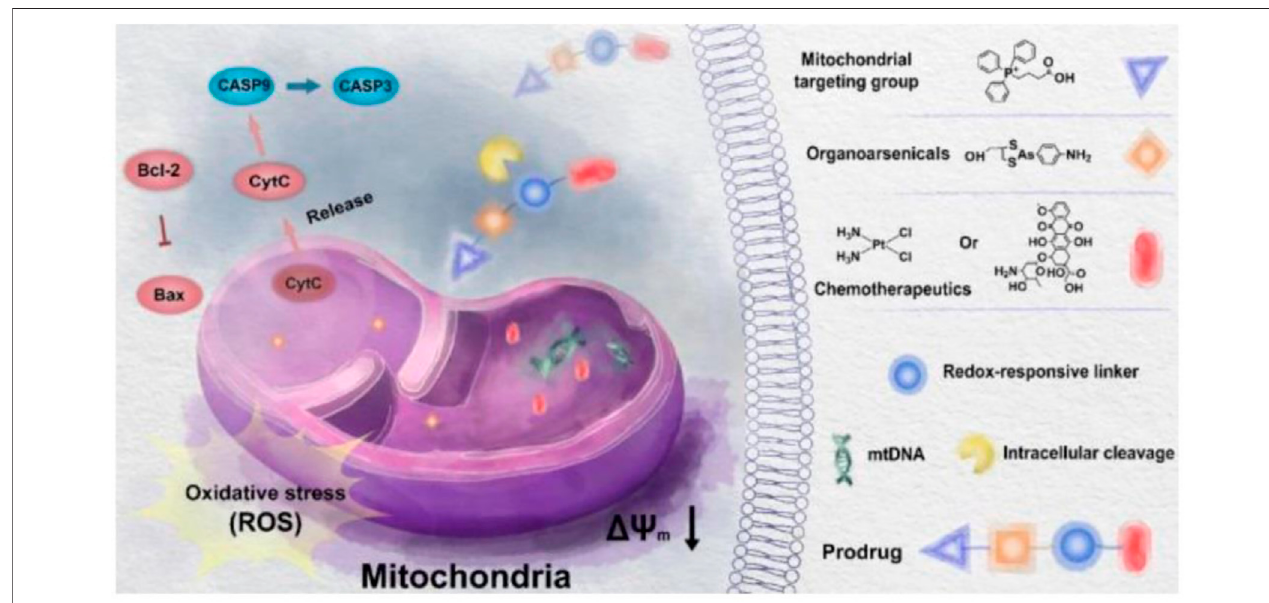
FIGURE 6 | Illustration mechanism of underlying mitochondria targeting organoarsenic prodrugs for bioenergetic cancer therapy (Luo et al., 2021).